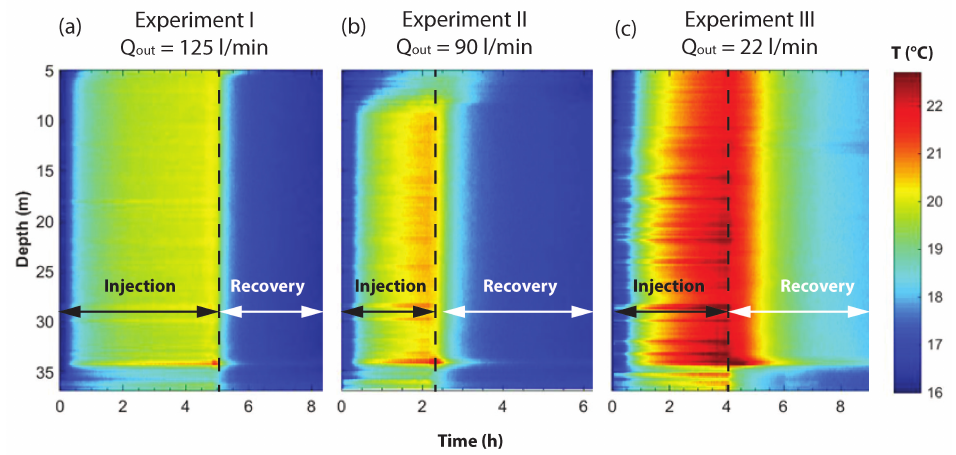
Figure 8. Raw FO-DTS measurements during and after heat injection for ( a ) convergent dipole configuration at Q = 125 l / min, ( b ) convergent dipole configuration at Q = 90 l / min and ( c ) perfect dipole configuration at Q = 22 l /